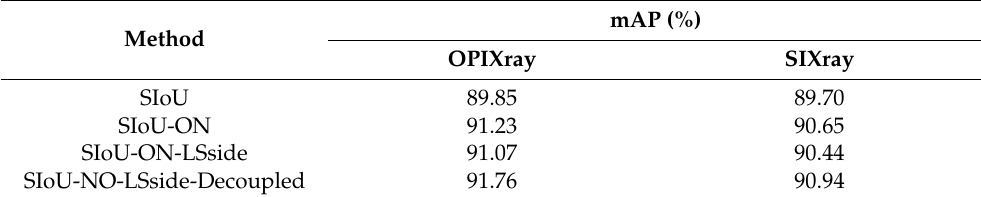
Table 6. Ablation study for OD-SIoU.